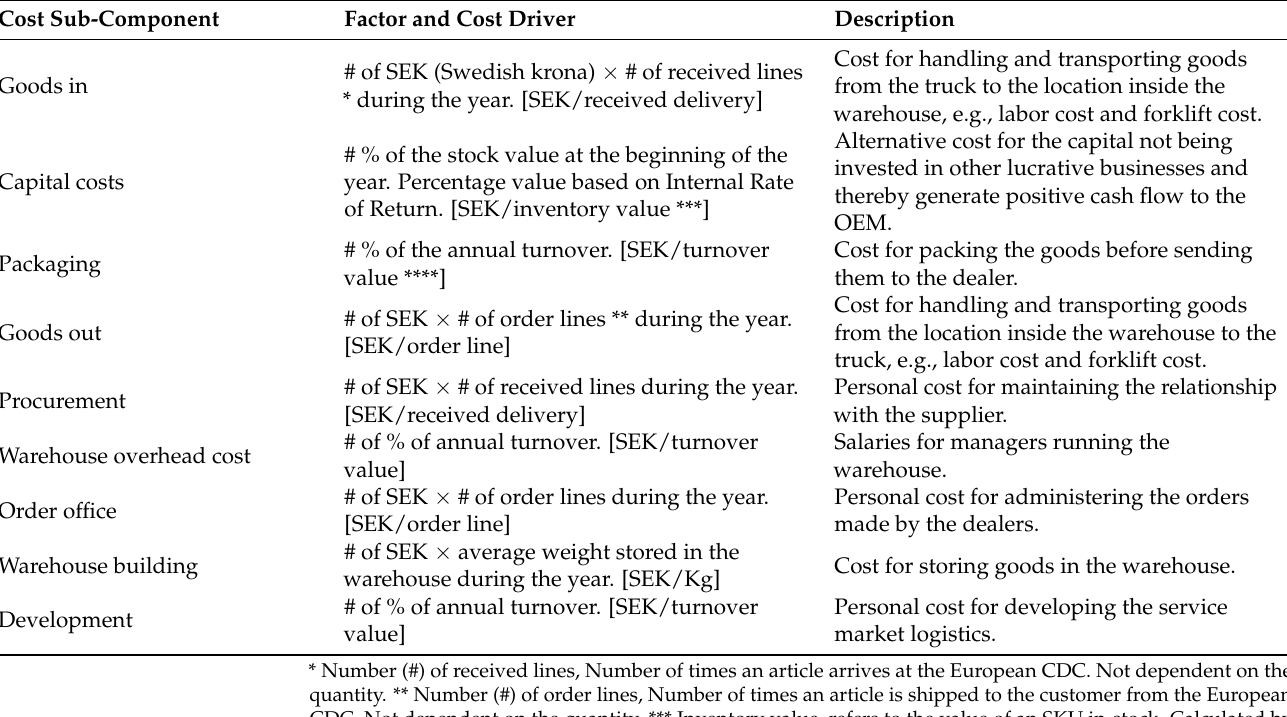
Table 3. Cost sub-components of